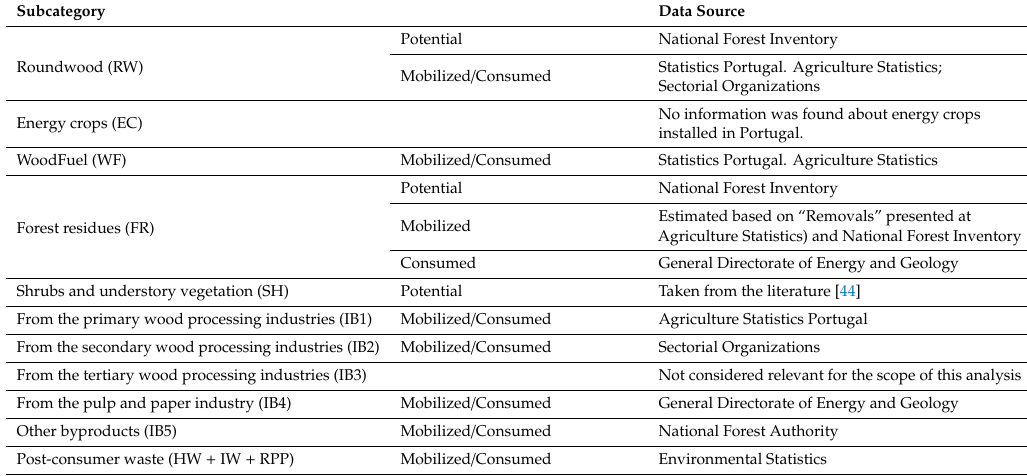
Table 3. Main data sources for characterizing the wood-based biomass sources in Portugal for 2016.